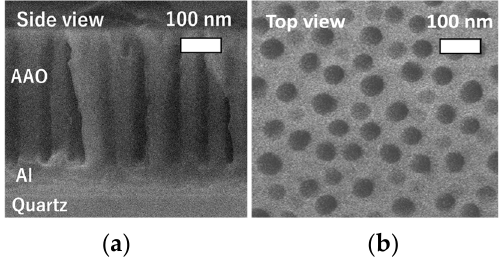
Figure 1. Cross sectional ( a ) and surface ( b ) SEM images of AAO nanostructure on the quartz crystal. Applied voltage was set as 40 V for 4 min in the oxalic acid